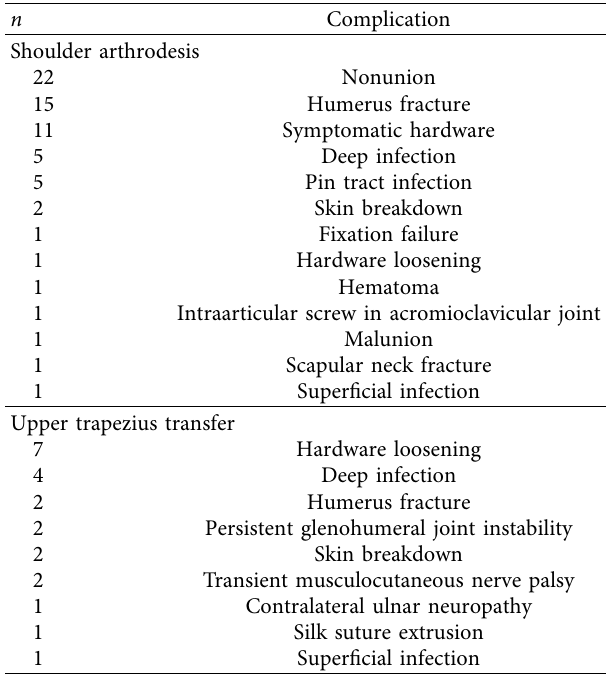
Table 3: Complications following shoulder arthrodesis and upper trapezius